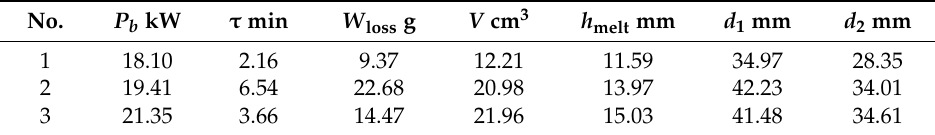
Table 8. Pareto-optimal solutions and the corresponding process conditions.